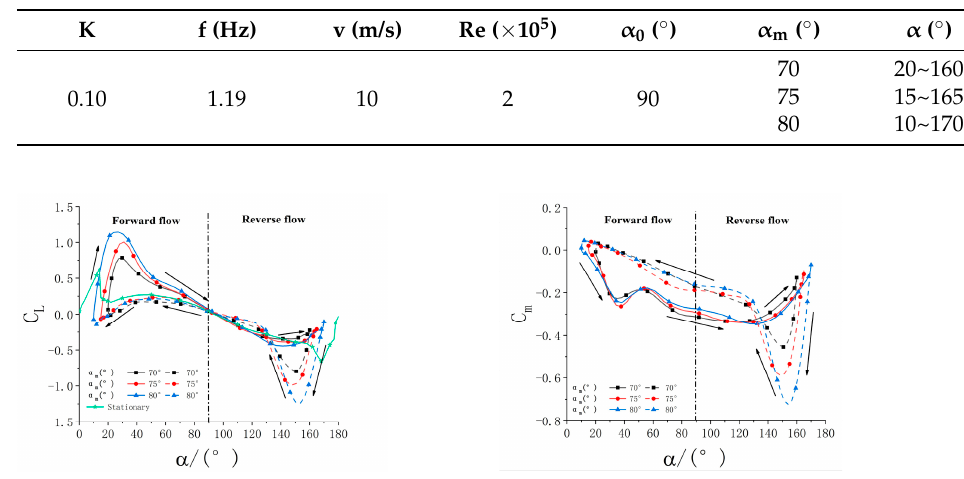
Figure 20. Lift coefficient, 1/4 chord moment coefficient during forward and reverse flow switching.